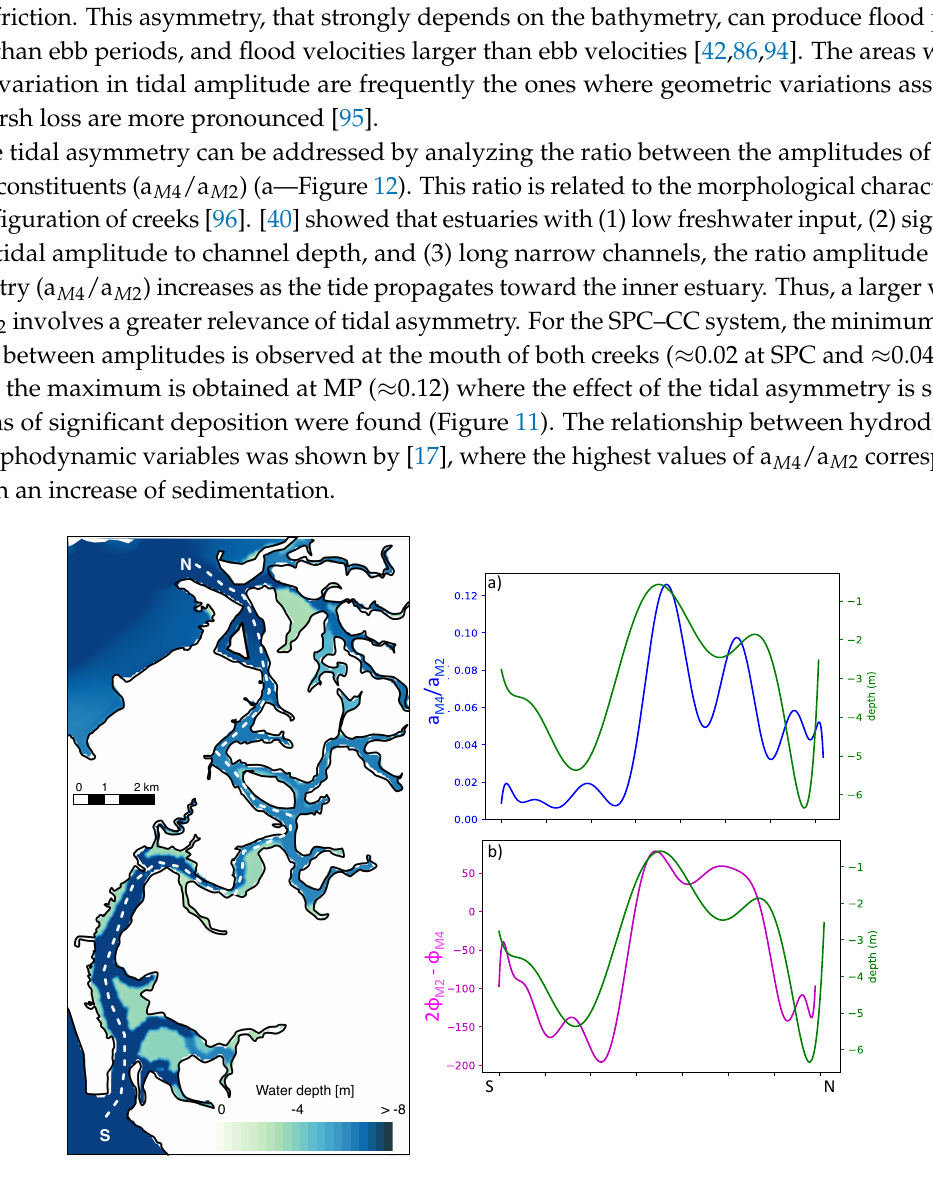
Figure 12. Hydrodynamic variables along the navigation channel: ( a ) a M 4 /a M 2 and ( b ) 2 φ M 2 + φ M 4 . Left panel: transect N-S (dashed